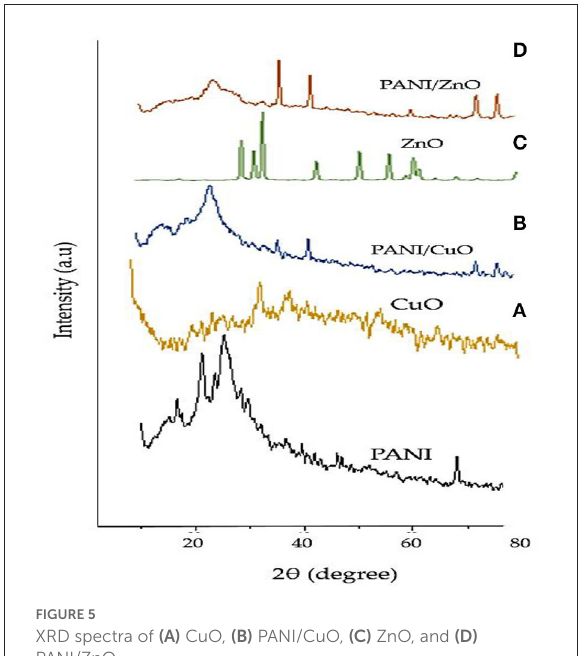
FIGURE5 XRD spectra of (A) CuO, (B) PANI/CuO, (C) ZnO, and (D) PANI/ZnO.